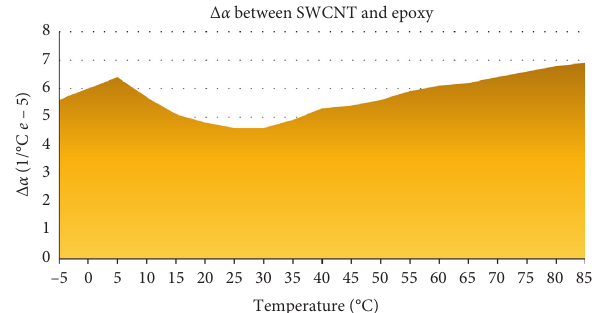
Figure 8: Mismatch between the CTEs of SWCNT and epoxy ( Δ α ) in temperature range of − 5 to 85 ° C in SWCNTE.